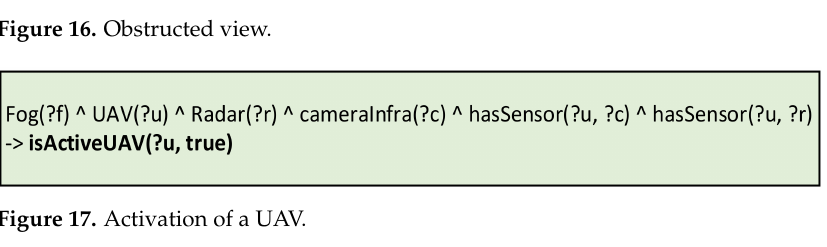
Figure 17. Activation of a UAV.